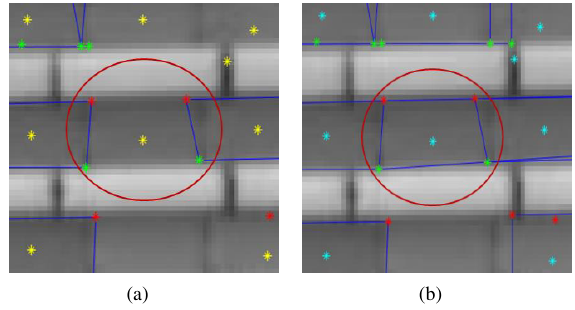
Figure 3. Iterative process case 1: a) four corners have been de- tected but are not combined so far. Possible centre points marked in yellow. b) newly added rectangle for the four existing corners with verified centre point